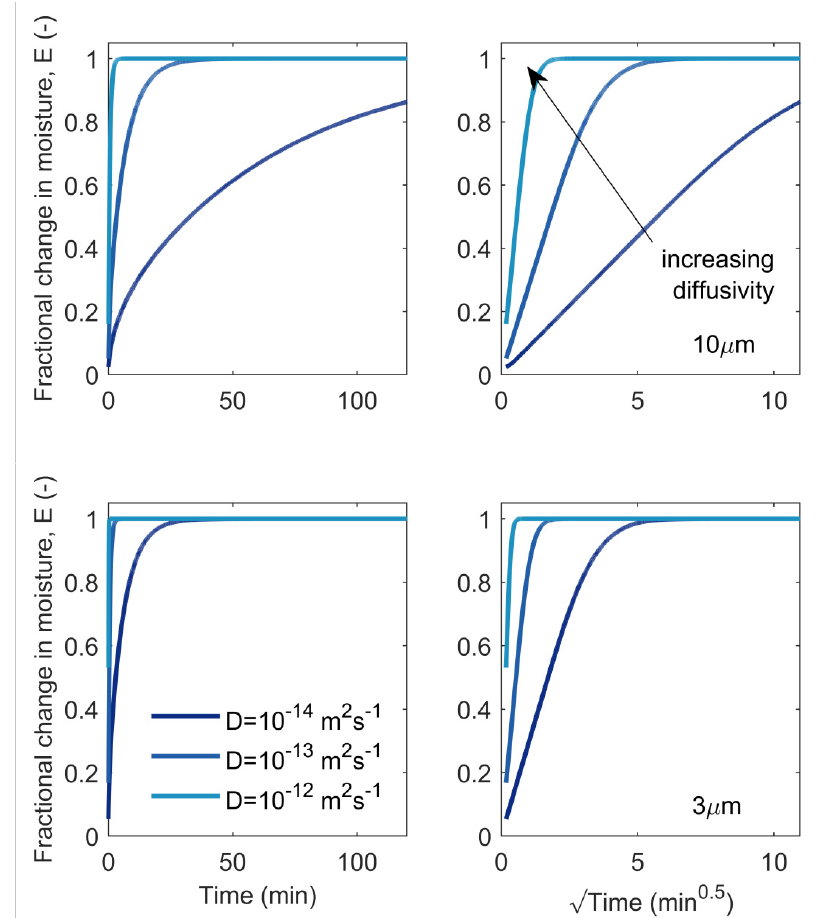
Figure 7. Sorption curves as predicted by Fickian diffusion into wood cell walls for L = 10 µm (upper panels) and L = 3 µm (lower panels).